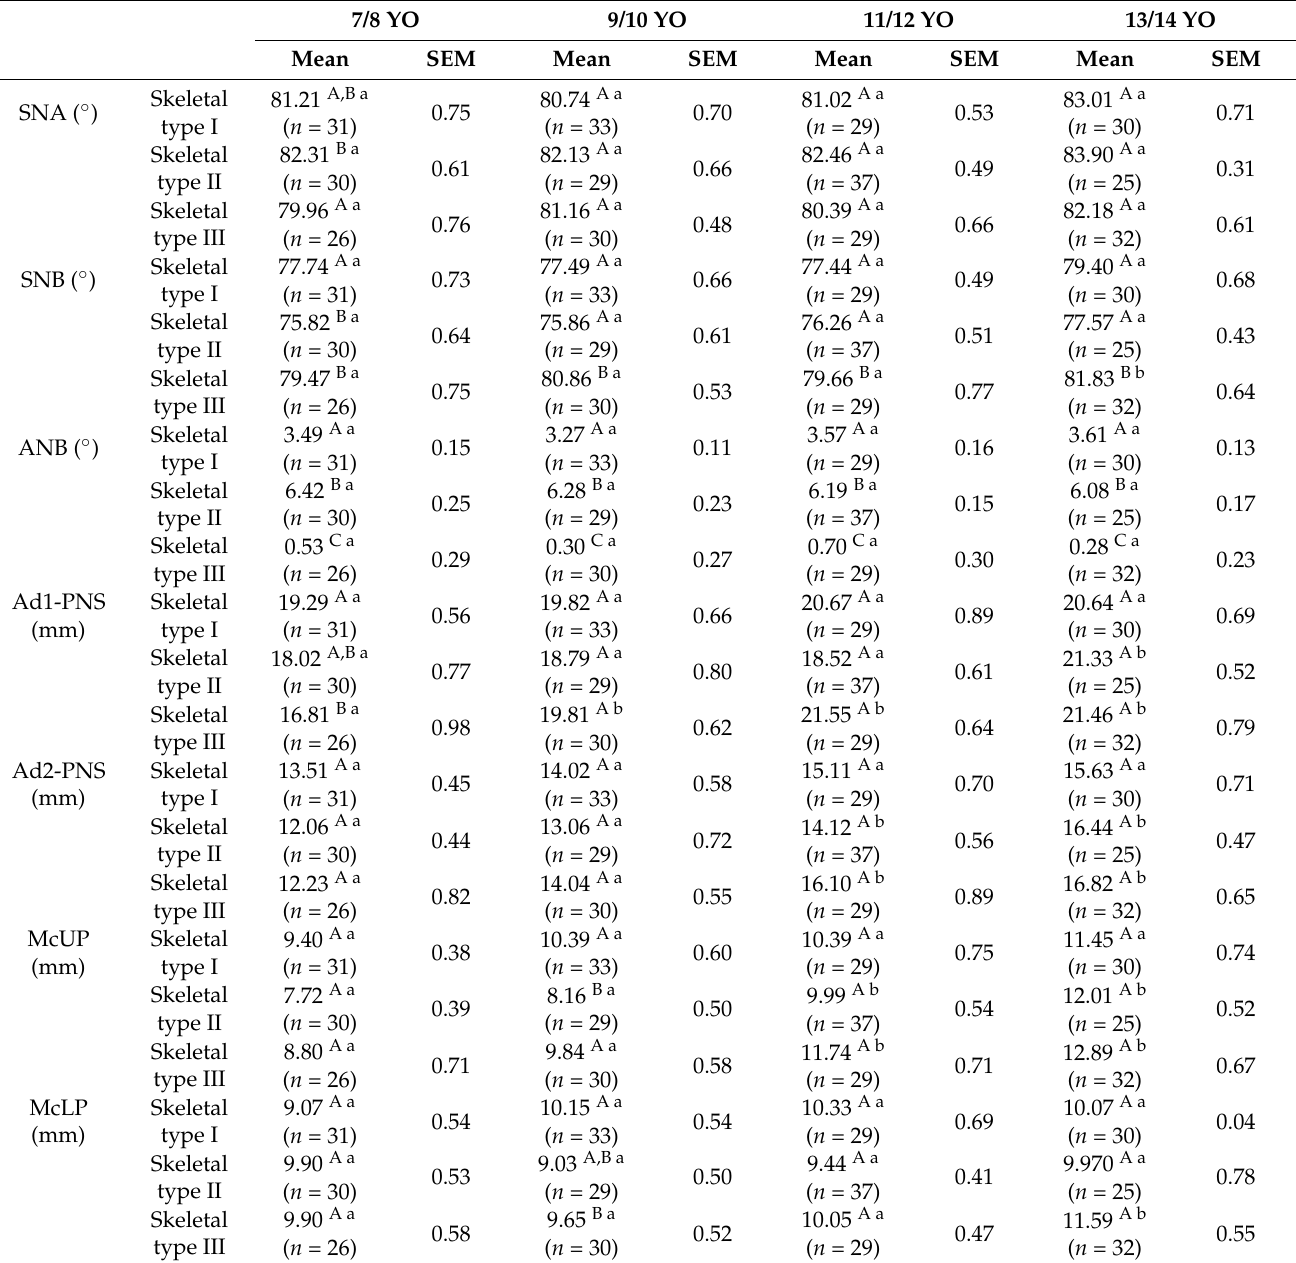
Table 2. Comparison of the cephalometric variables and upper pharyngeal airway measurements among 7–14-year-old children in the three skeletal